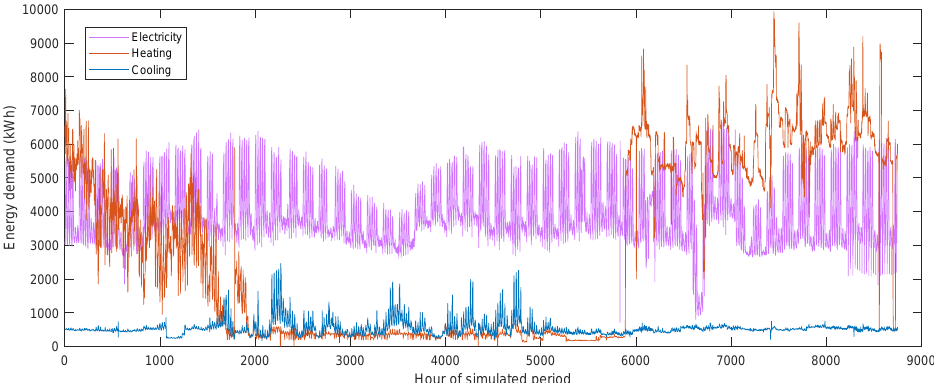
Figure A3. Energy demand of the Chalmers campus over the simulated period. The simulated period is from 1 March 2016 to 28 February